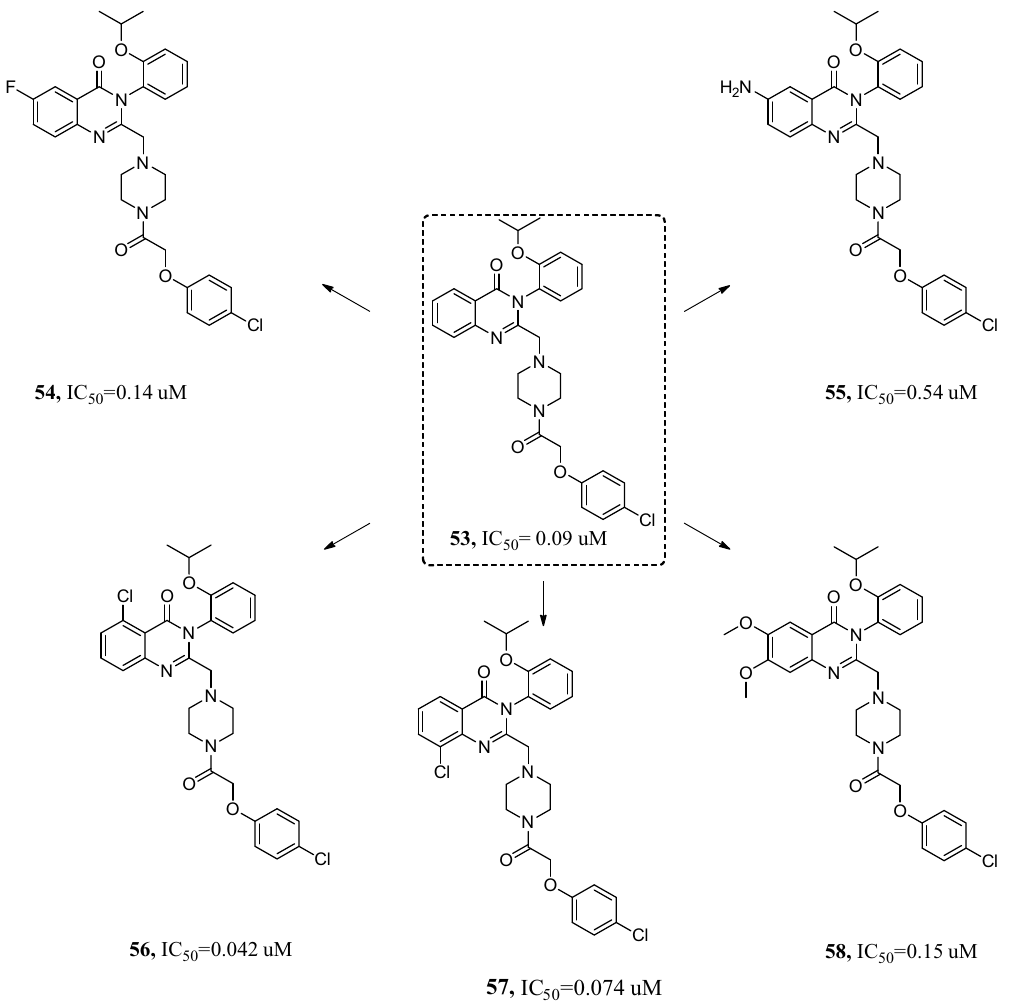
Figure 18: Chemical structures of compounds 53 –